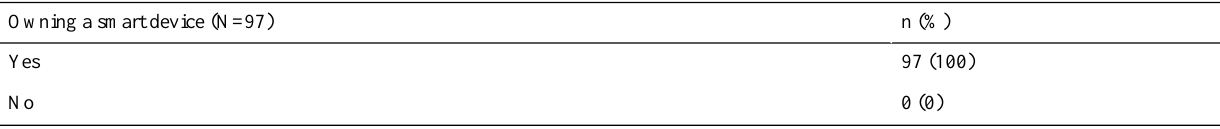
Table 2. Use of smart devices and medical applications.